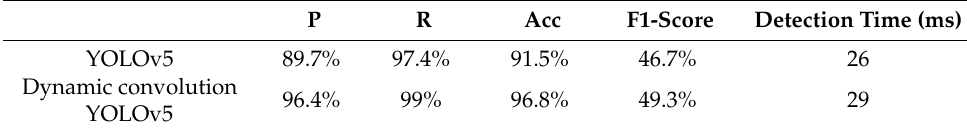
Table 3. Comparison results of the dynamic convolution experiment.